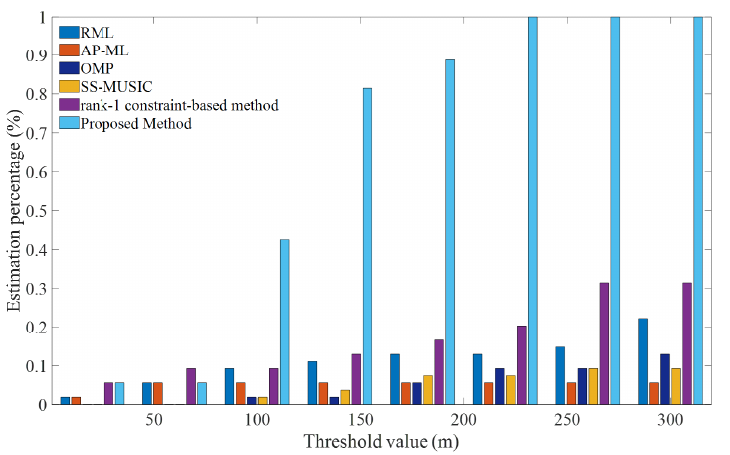
Figure 7. Statistical result of the estimation percentage in terms of target height across different threshold